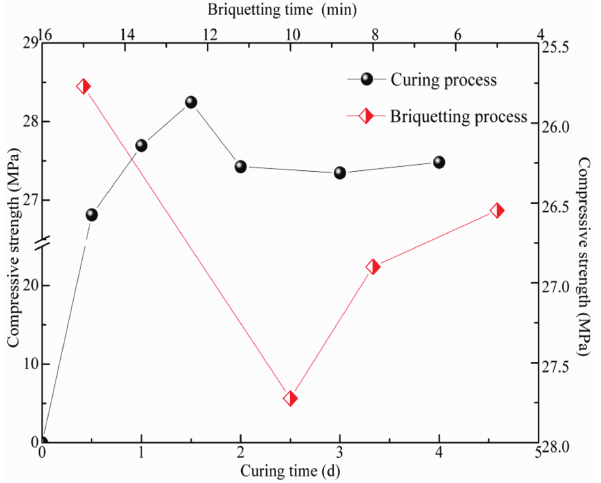
Figure 7: Effect of curing and briquetting time on compressive